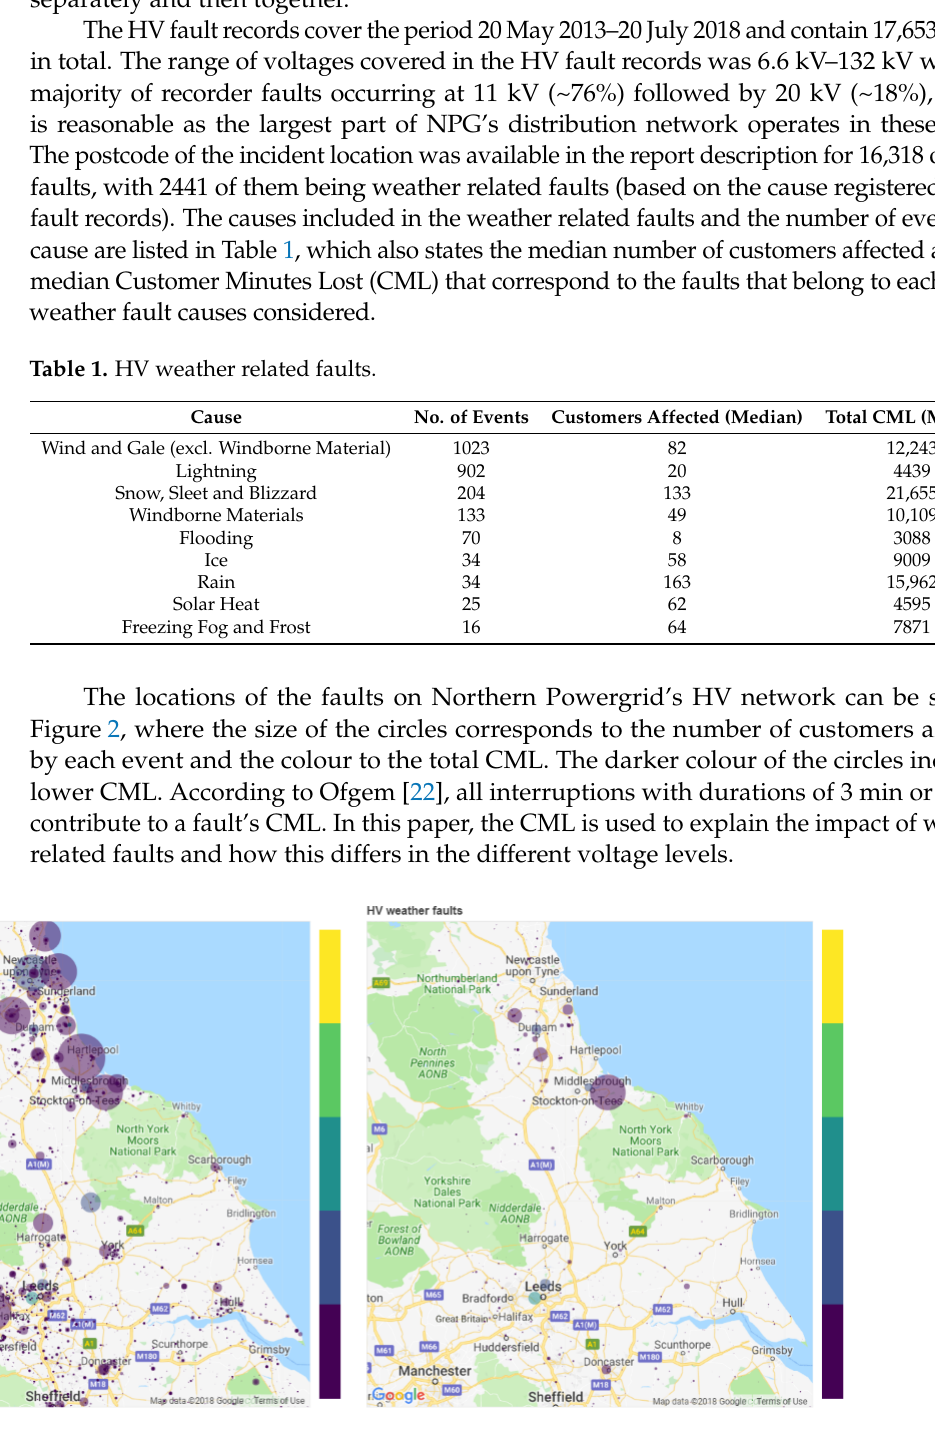
Figure 2. HV faults in NPG distribution network licence area–darker colour of circles indicates lower CML ( Left : all faults, Right : weather related